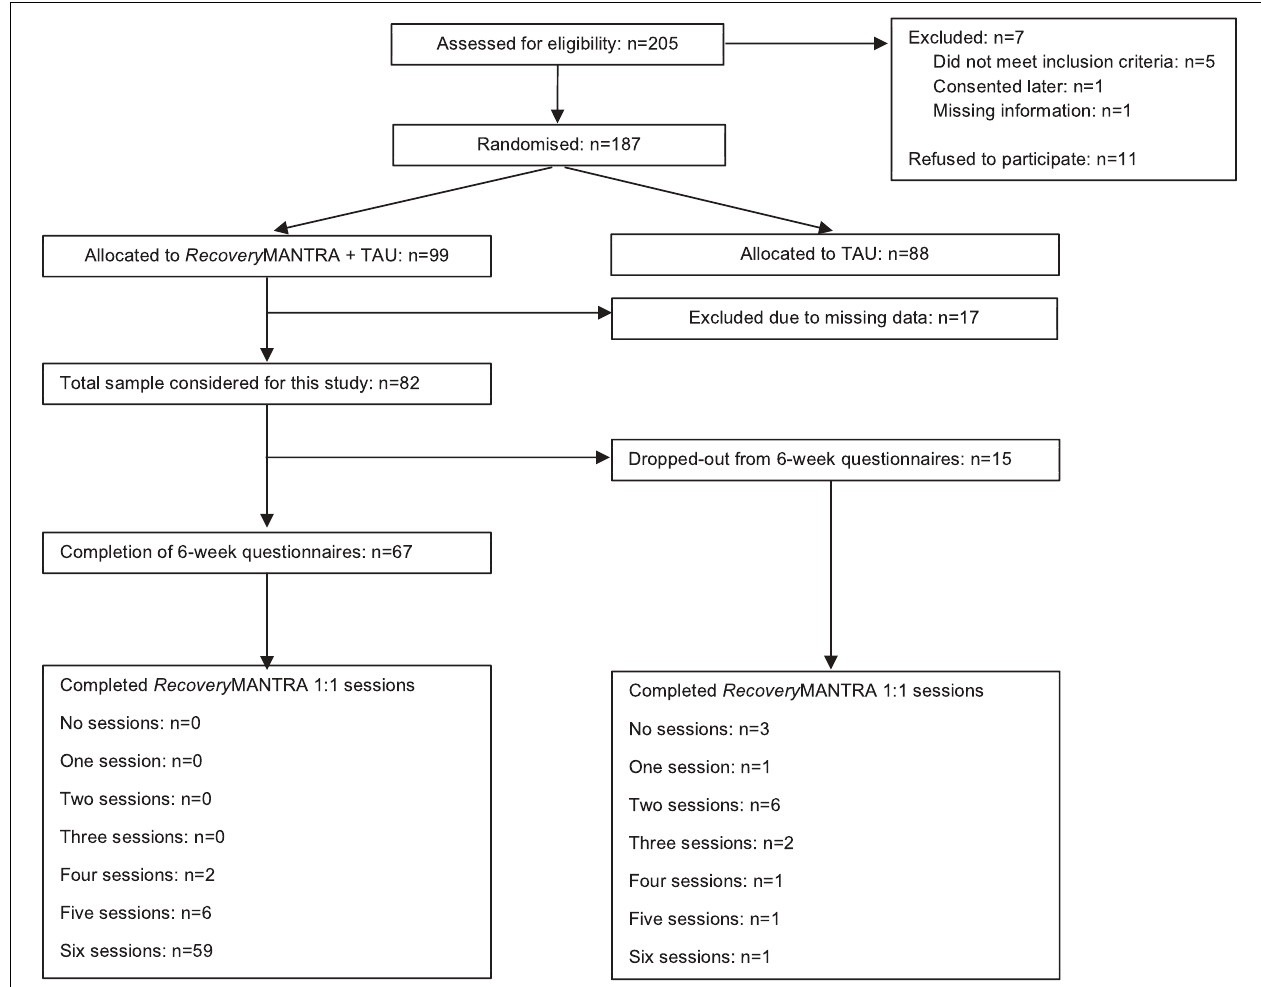
FIGURE 2 | Study flow-chart. This figure describes the process of assessing, randomizing and assessing participants and includes number of participants who completed the 6 weeks assessments and the Recovery MANTRA intervention sessions.